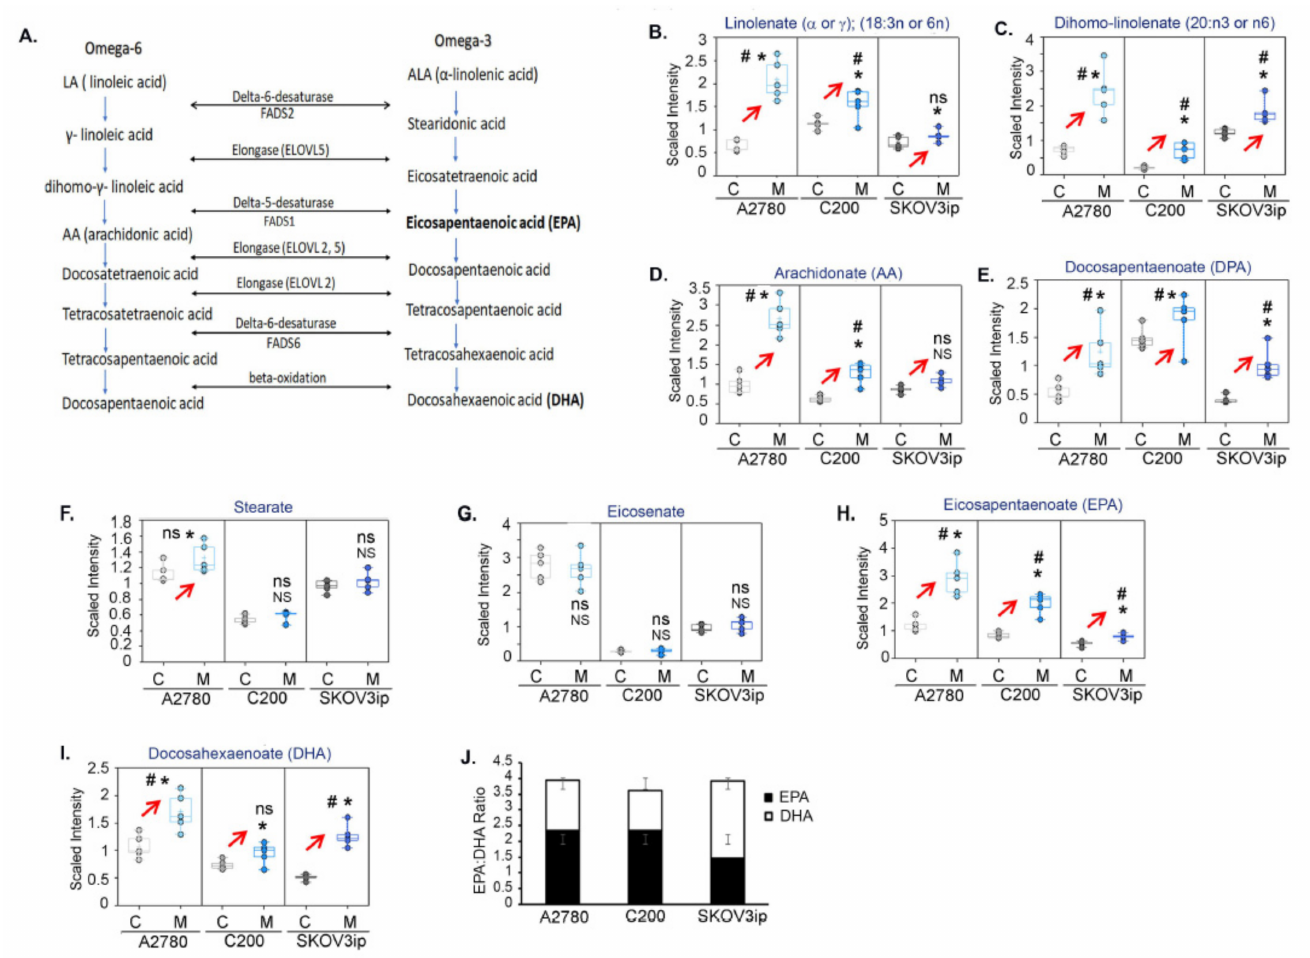
Figure 6. Metformin enhances DHA and EPA metabolism. ( A ) Schematic briefly depicting the omega-6 (LA, linoleic acid) and omega-3 fatty (ALA, alpha-linolenic acid) acid metabolism leading to generation of downstream lipid mediators. Several metabolite intermediates that were increased in most cells by metformin included ( B ) linolenate, ( C ) di-homo linolenate, ( D ) arachidonate (AA), ( E ) docosapentaenoate (DPA), ( F ) Stearate, ( G ) eicosenate, ( H ) eicosapentaenoate (EPA), and ( I ) do- cosahexaenoate (DHA). ( J ) Ratio of the level of EPA and DHA in A2780, C200, and SKOV3ip. For all box-plot graphs, * p ≤ 0.05, NS = p non-significant, # q ≤ 0.05, ns = q non-significant when metformin treated compared to